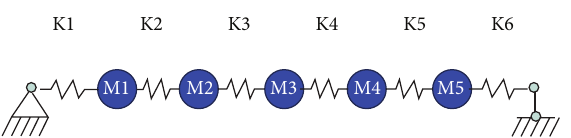
Figure 4: Idealized lumped-mass model for the steel bridge struc-